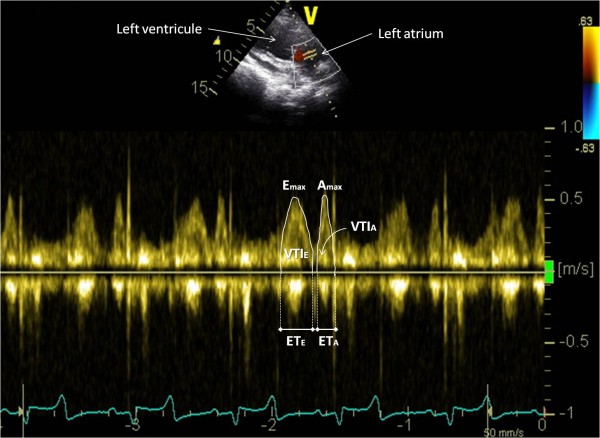
Mitral inflow velocity spectrum obtained from a left parasternal long axis four chamber view. The peak early filling velocity (Emax), the peak filling velocity of the transmitral flow during atrial contraction (Amax), the E-peak and A-peak velocity time integral (VTIE and VTIA respectively) and the E-peak and A-peak ejection times (ETE and ETA respectively) were measured as shown.